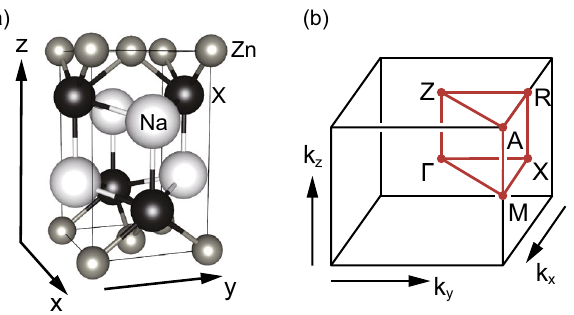
Figure 1. ( a ) Crystal structure of matlockite-type NaZn X ( X = Sb and Bi) in space group P 4/nmm (# 129). Na, Zn, and X atoms are colored by white, grey, and black, respectively. The unit cell is represented by a solid (black) box. ( b ) Corresponding tetragonal first Brillouin zone. High-symmetry momenta are colored